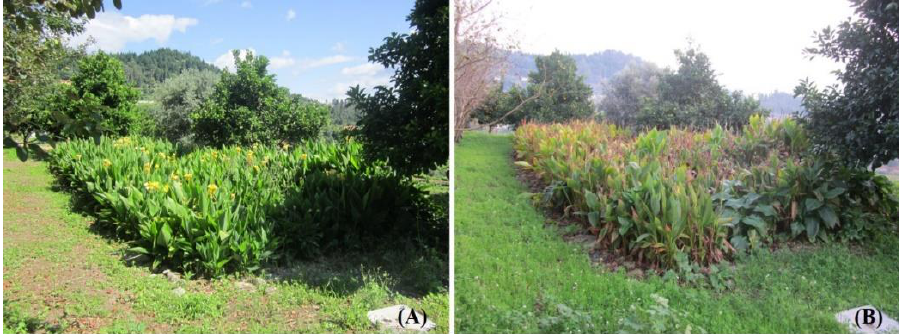
Figure 1. Constructed wetland for wastewater treatment at a tourism house: ( A ) hot season (spring/summer) and ( B ) cold season (autumn/winter).